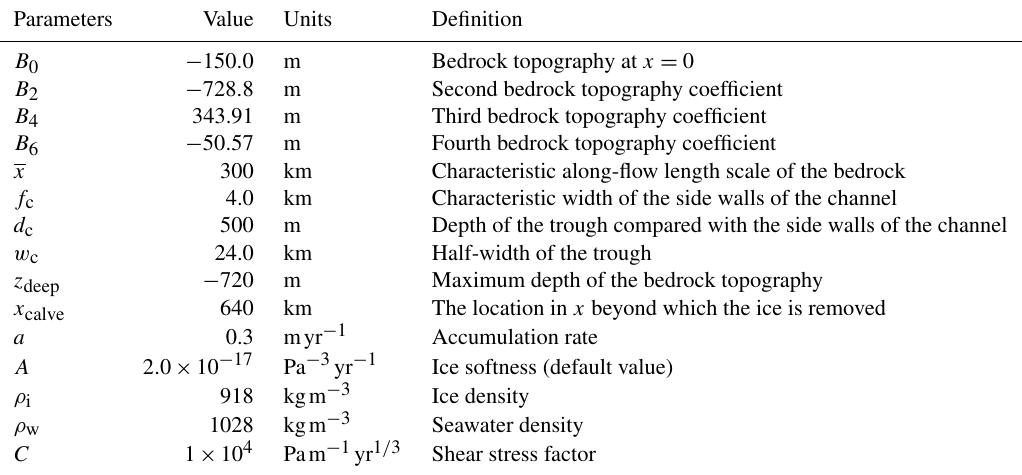
Table 2. Parameter values for the MISMIP+ experiments.